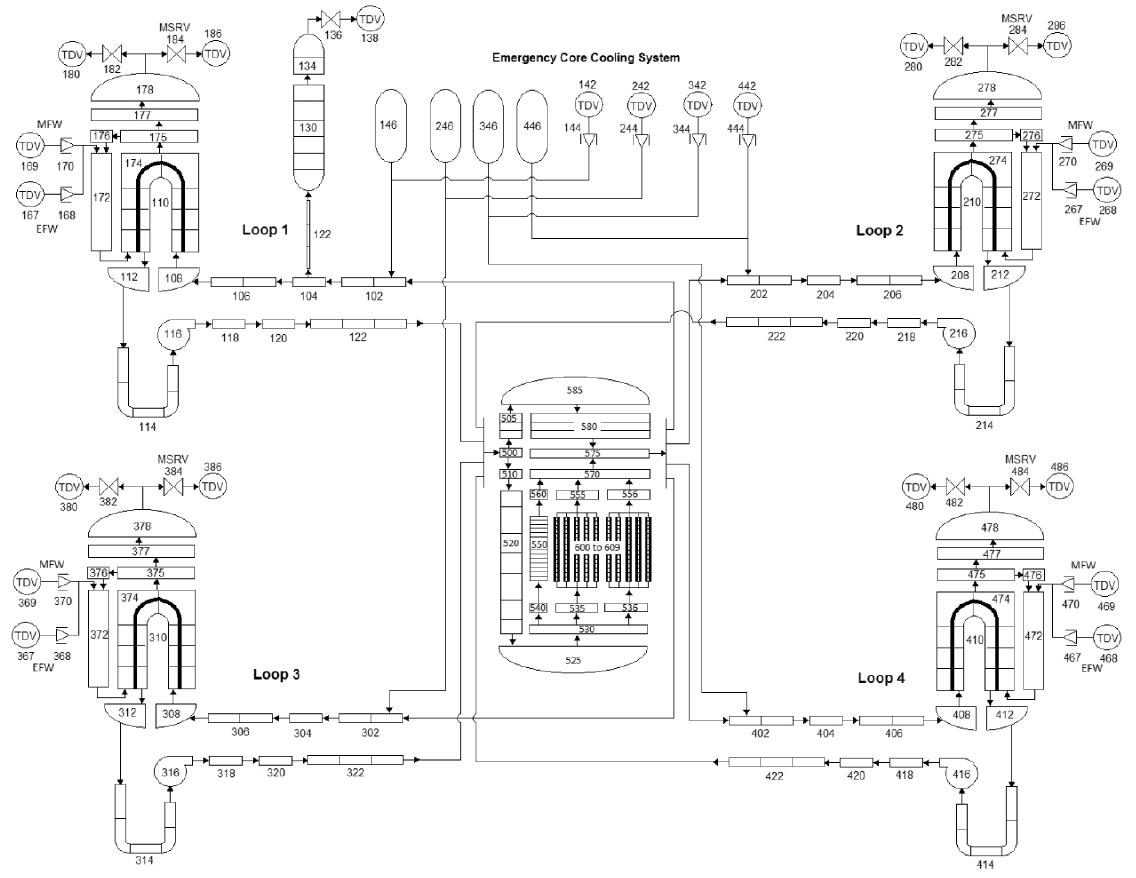
Fig. 1. RELAP5-3D nodalization for the Angra 2 PWR.